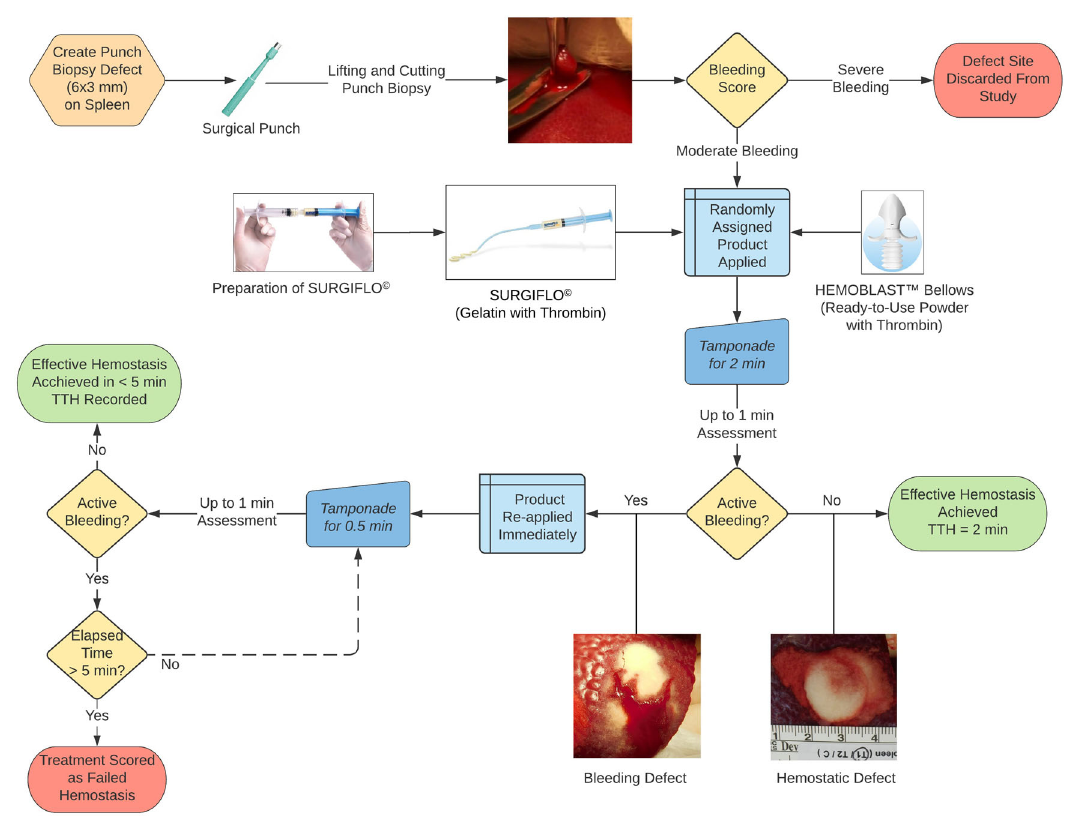
Fig. 1 Schematic illustration of the porcine spleen hemostasis model. After a punch biopsy defect is created and bleeding scored, randomly assigned test material (Surgi fl o or Hemoblast) and tamponade are applied for 2 min and evaluated for up to 1 min. If hemostasis is achieved following this initial 2-min period of tamponade and main- tained for the full 1-min assessment period, time to hemostasis (TTH) is recorded as 2 min. If active bleeding is presentat any time during the